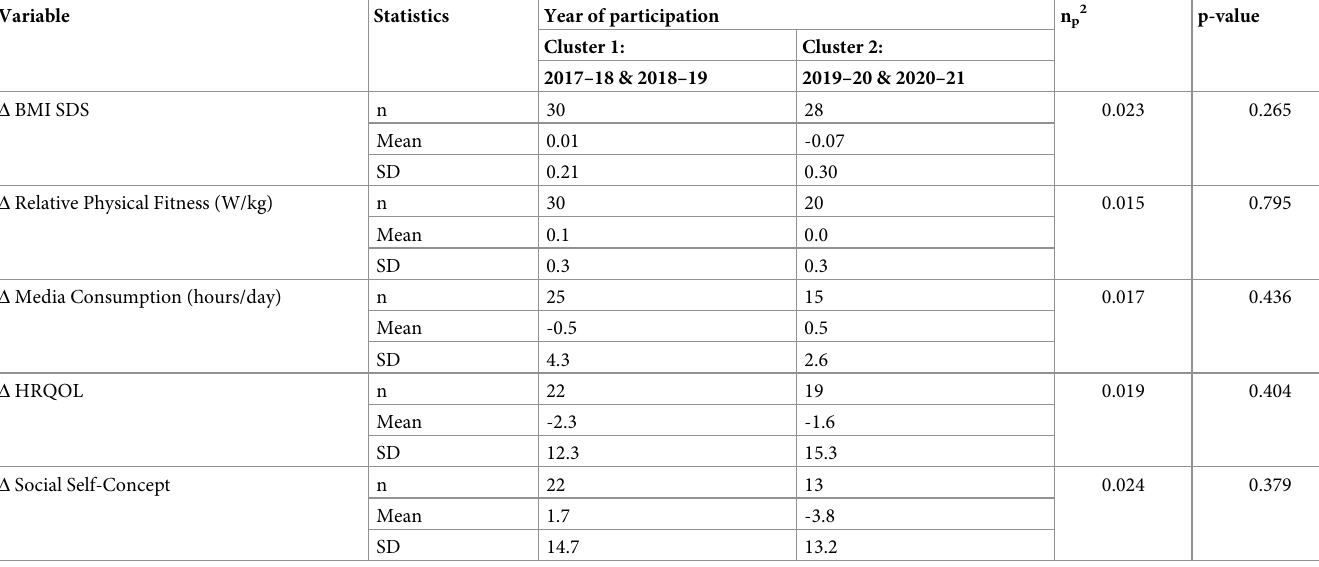
Reported means are adjusted for age, gender, and baseline value; Δ , difference in data after 11-month intervention (t2) from baseline data (t1); HRQOL, health-related quality of life; SD, standard deviation; p-value represents the significance of year of participation as an independent variable in ANCOVA; n p2 , partial eta squared, used as a measure of effect size of the independent variable; HRQOL and social self-concept are based on scores ranging from 0 (lowest) to 100